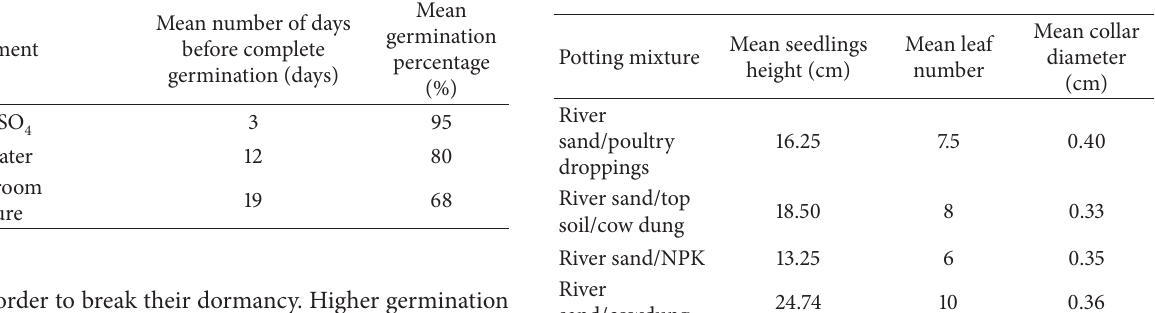
Table 2: Effects of potting mixtures on growth parameters of T. indica